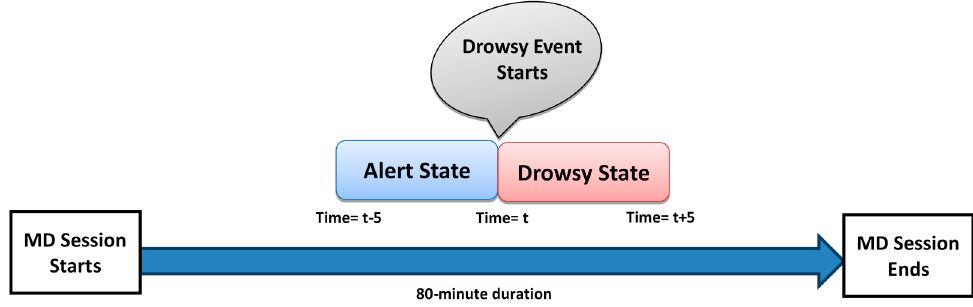
Figure 2. Drowsy and alert event marking process using video recordings from the MD session (t is in